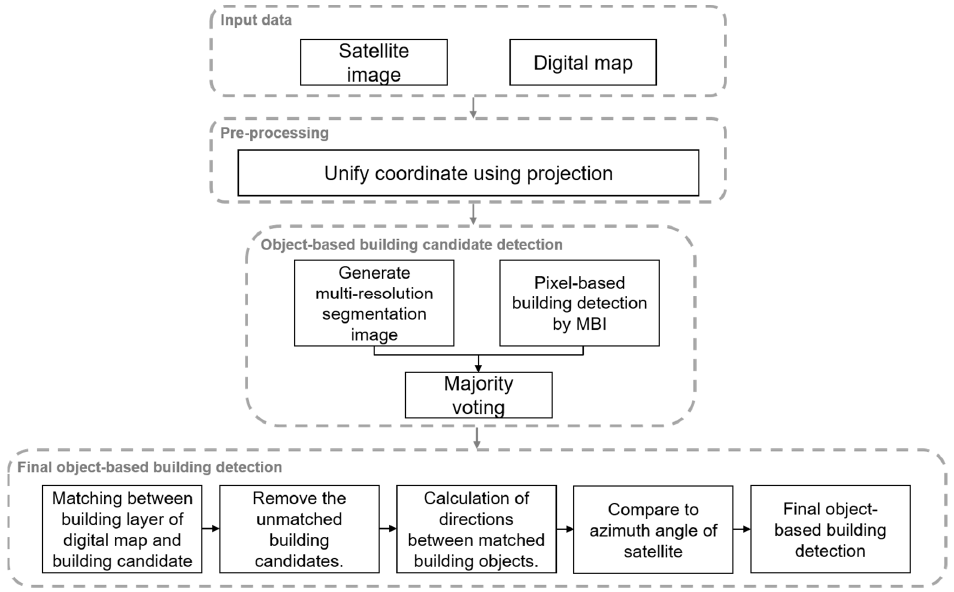
Figure 1. Flowchart of the proposed method.